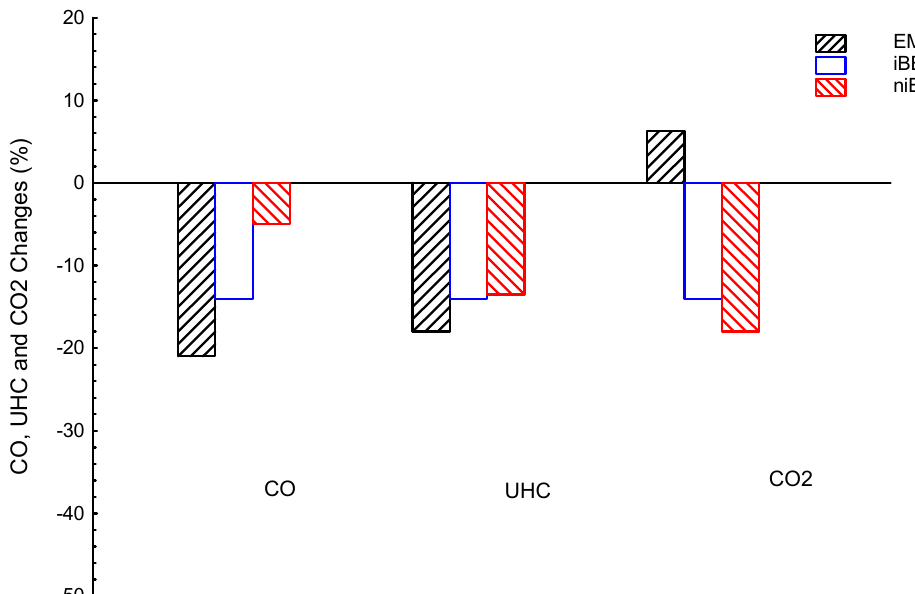
Figure 9. CO, CO 2 , and UHC emissions averages for ternary blended fuels of bio-ethanol–bio- methanol–gasoline (EM), iso-butanol–bio-ethanol–gasoline (iBE), and n-butanol–iso-butanol–gasoline (niB); gasoline is the reference line.